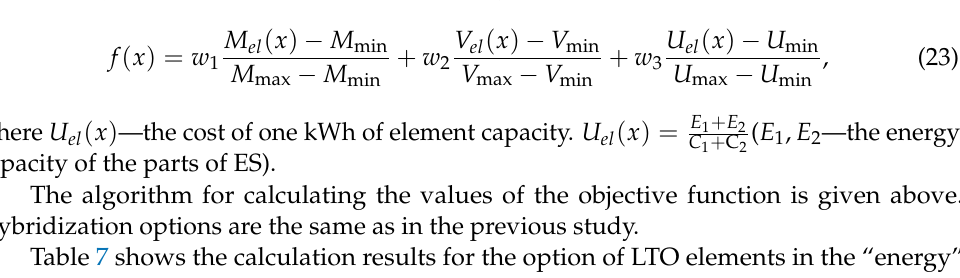
Table 7. Results of calculations of ES parameters.